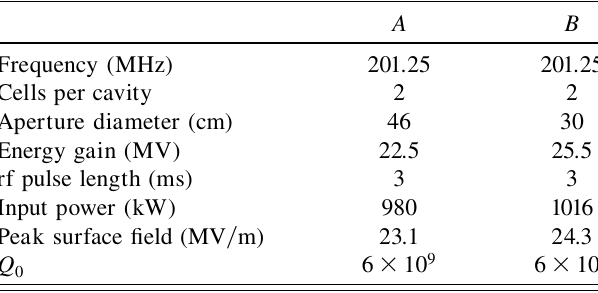
TABLE X. Parameters for superconducting cavities.